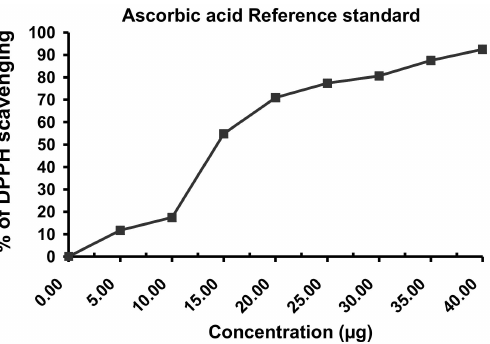
Figure 10. Antioxidant effect of ascorbic acid as